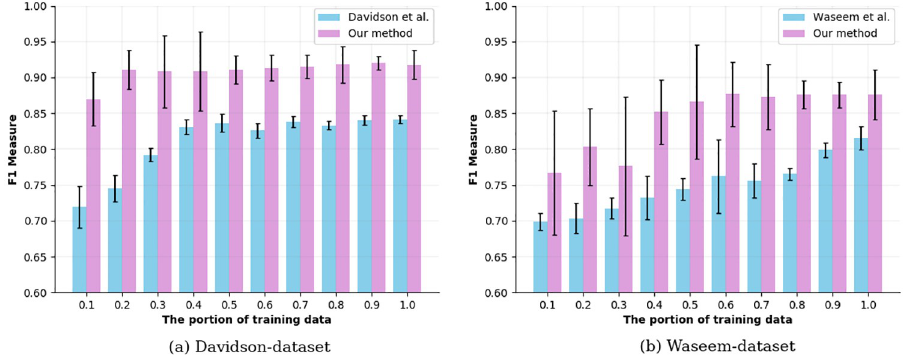
Fig 2. The performances of hate speech detection models trained with a variation of training sets on Davidson and Waseem datasets. The x-axis is the portion of the training and validation sets used for training our BERT-based model and the baselines, the y-axis shows the